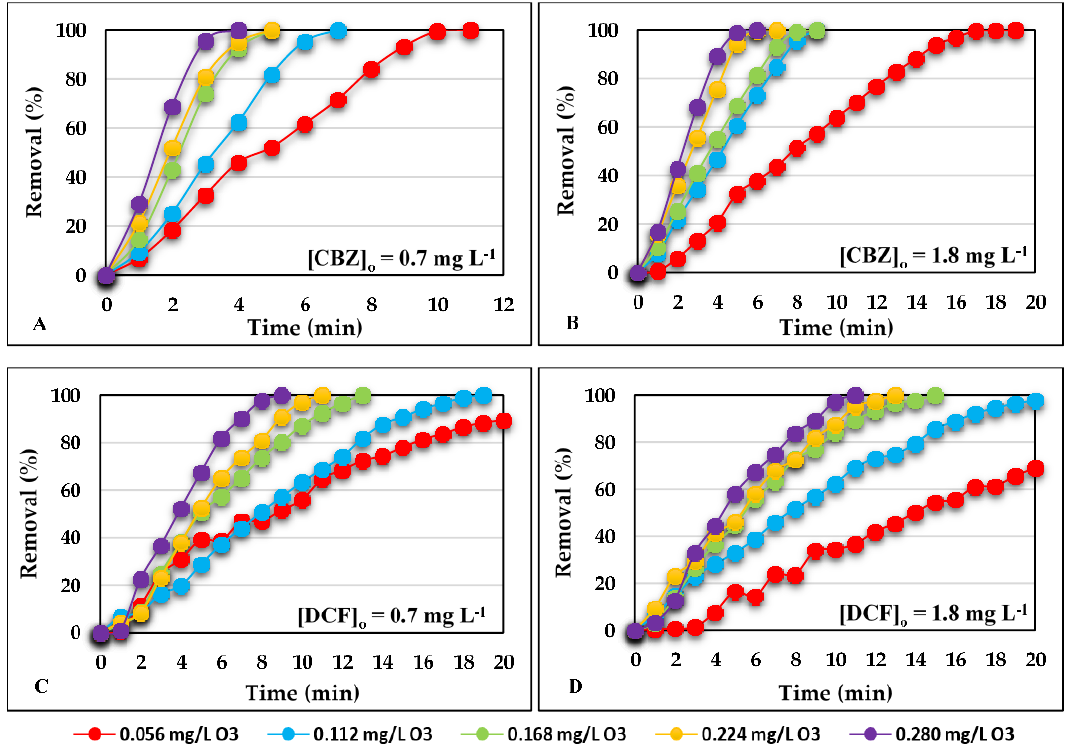
Figure 3. Removal percentages of CBZ and DCF over time at different ozone 0.056 mg L −1 – 0.280 mg L −1 : ( A ) [CBZ] 0 = 0.7 mg L − 1 ; ( B ) [CBZ] 0 = 1.8 mg L − 1 ; ( C ) [DCF] 0 = 0.7 mg L − 1 ; ( D ) [DCF] 0 = 1.8 mg L − 1 .